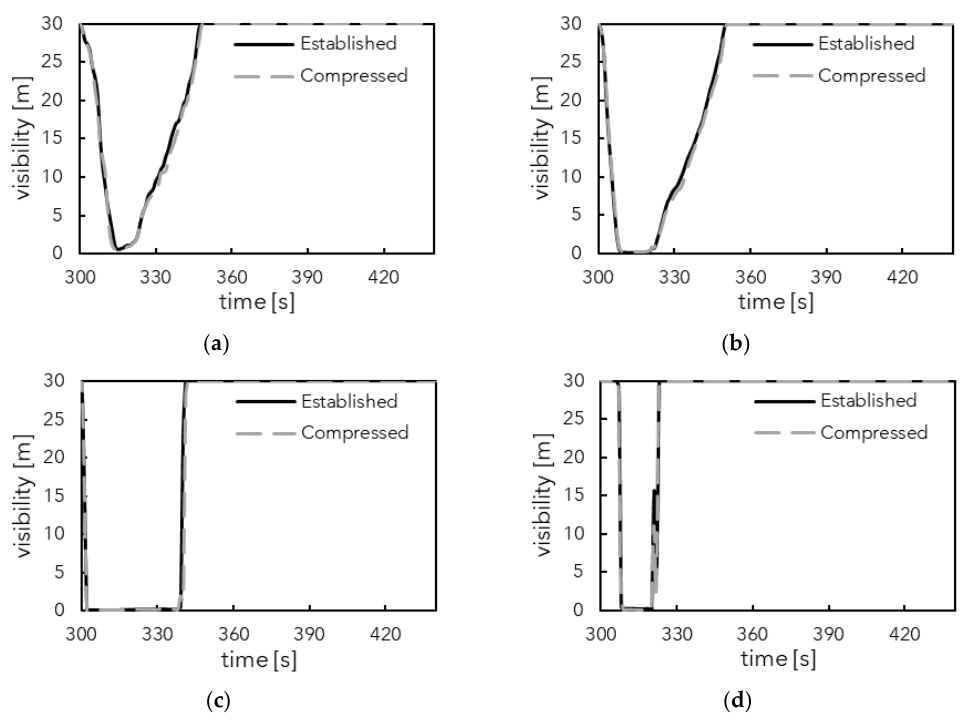
Figure 8. Additional results for the means of escape phase: ( a ) spatially-averaged visibility 1.5 m from floor level; ( b ) spatially-averaged visibility 2 m from floor level; ( c ) visibility at the apartment door 2 m from floor level; and ( d ) visibility at the stair door 2 m from floor level.